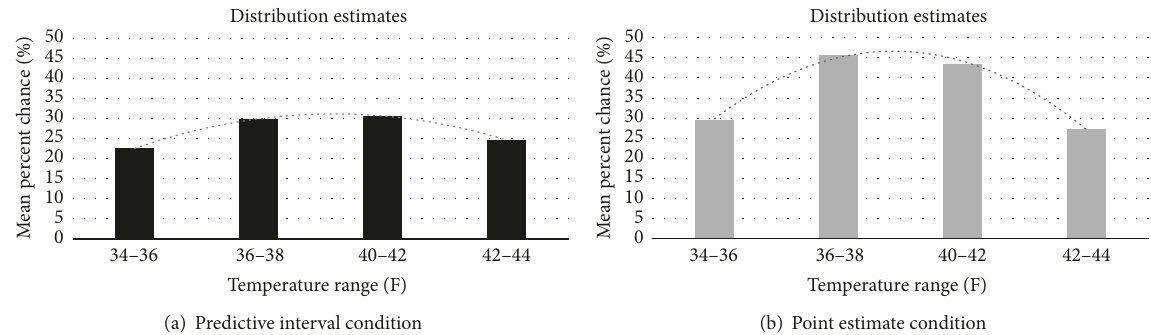
Figure 8: Mean percent chance estimates for values within the predictive interval (a) and point estimate (b) conditions in Experiment